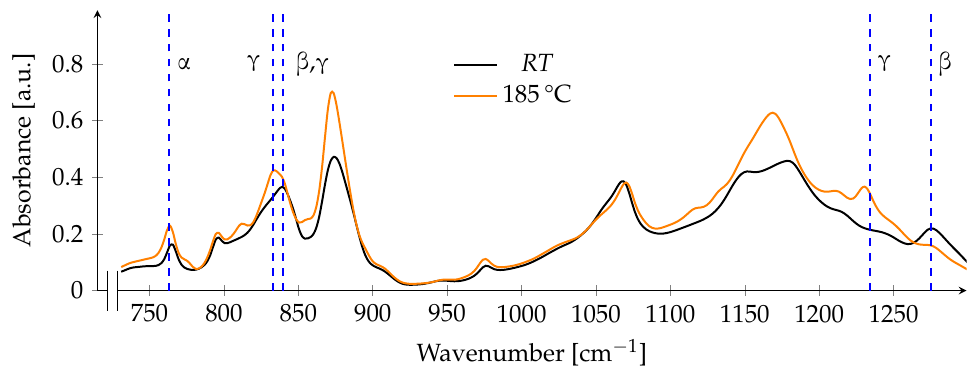
Figure 5. FTIR spectrum before and after annealing at 185°C. Dashed blue lines indicate the main absorption bands of the respective phases at A 763 , A 833 , A 840 , A 1234 and A 1275 .